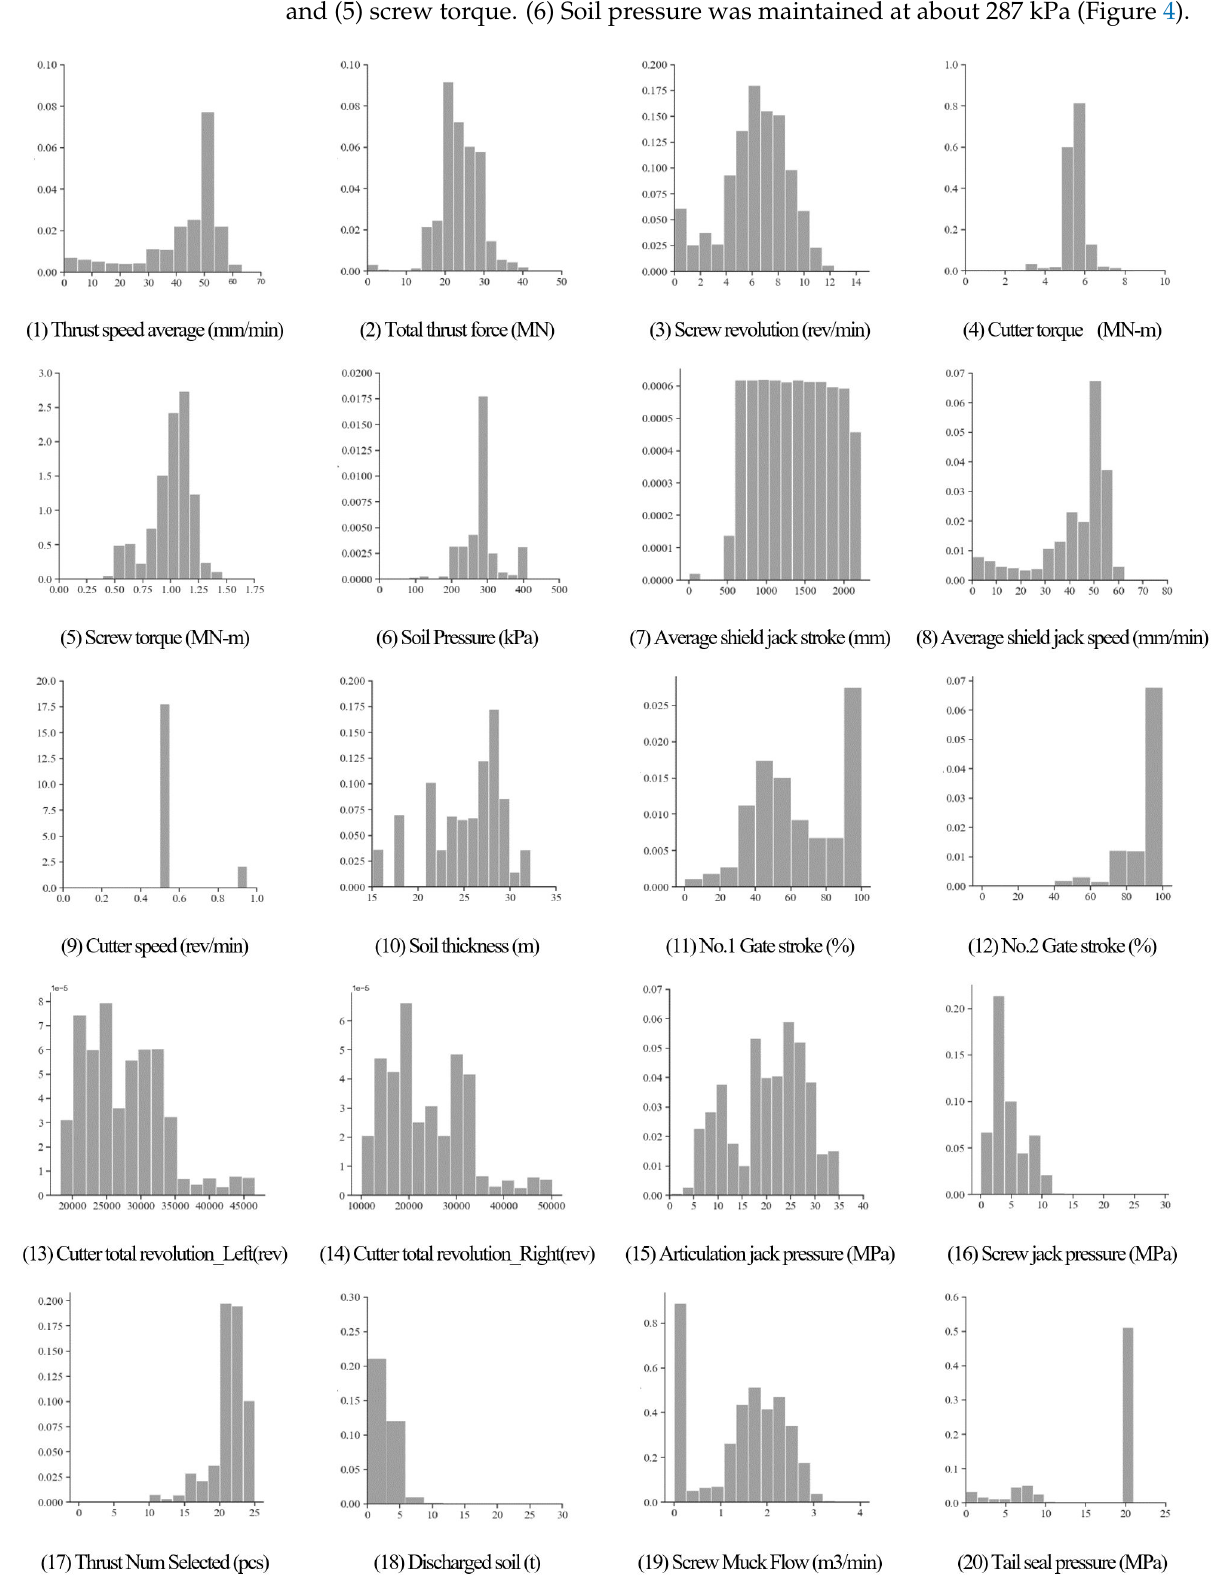
Figure 2. Distribution of data for feature selection.